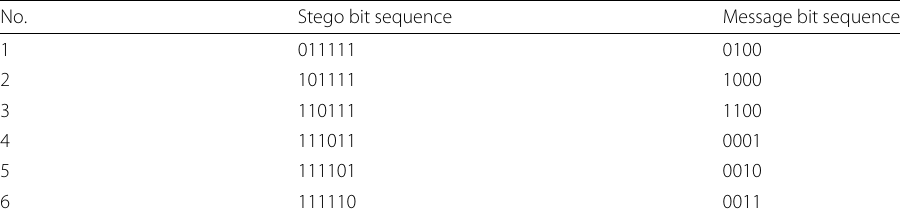
Table 1 Bit sequences extracted with parameter w = 2 from 5 coefficients whose LSBs are 1s and 1 coefficient whose LSB is